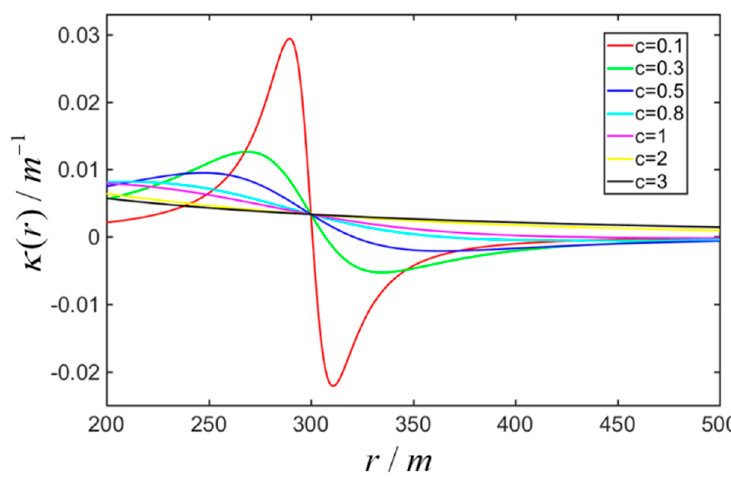
Figure 5. Vector field curvature κ versus r in different c ( rd = 300 m).